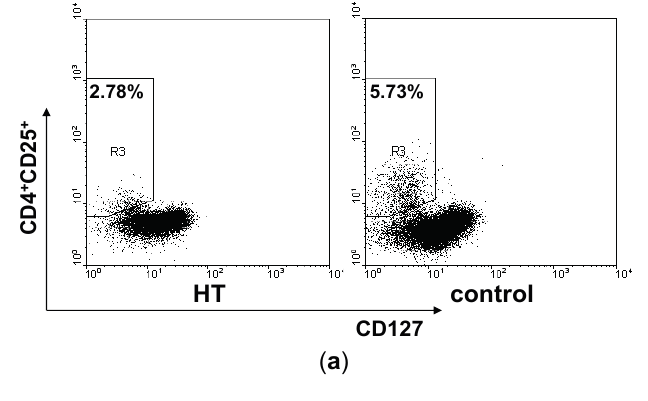
Figure 2. Reduction of regulatory T cells in HT patients. PBMCs from HT patients and healthy controls were stained for cell surface molecule CD4, CD25, CD127 and analyzed by flow cytometry. ( a ) Representative dot plots from HT patients and healthy controls are shown. Values correspond to the percentage of Treg cells. We used isotype controls to determine the positive cells, and all the values are gated on the CD4 + cells; ( b ) Percentages of Treg cells were compared between HT patients and healthy controls and ( c ) Levels of Foxp3 mRNA in PBMCs from HT patients and healthy controls. * p < 0.05; ** p <